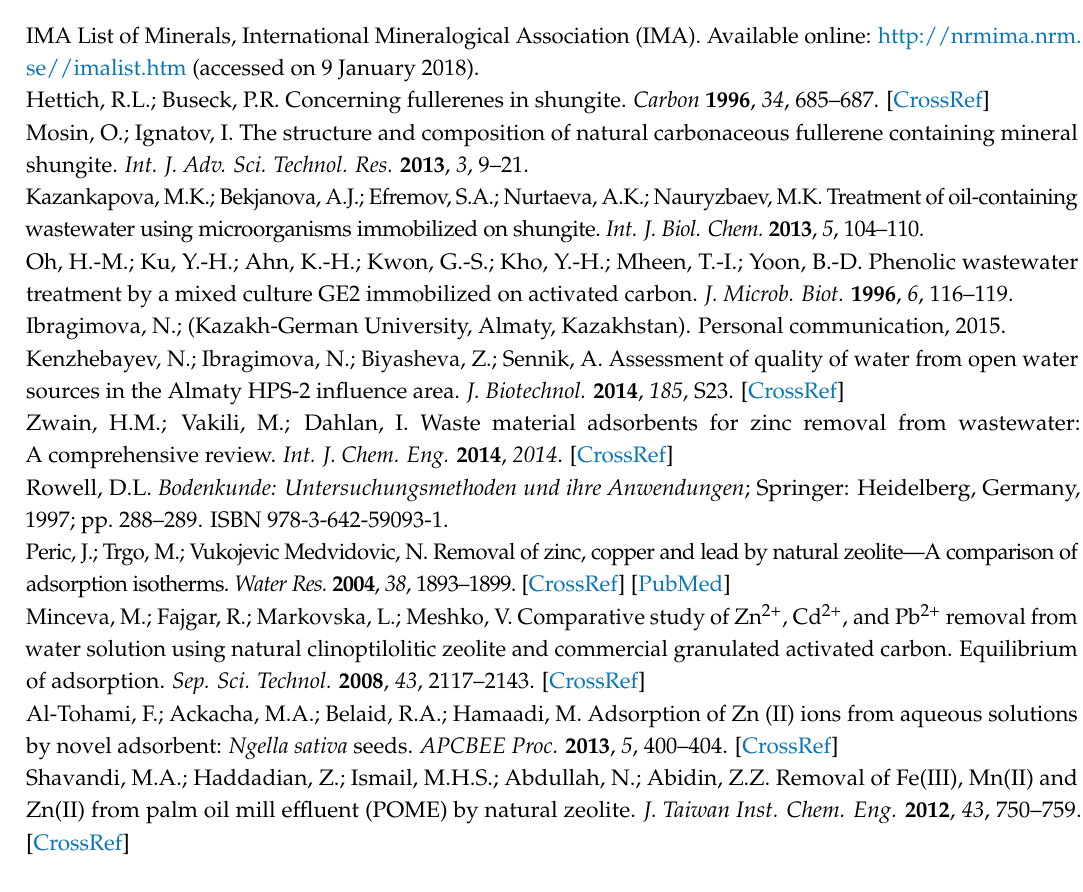
Table S1: Results of the chemical characterization of the Taurit used. Average values for three replicates with coefficients of variation always